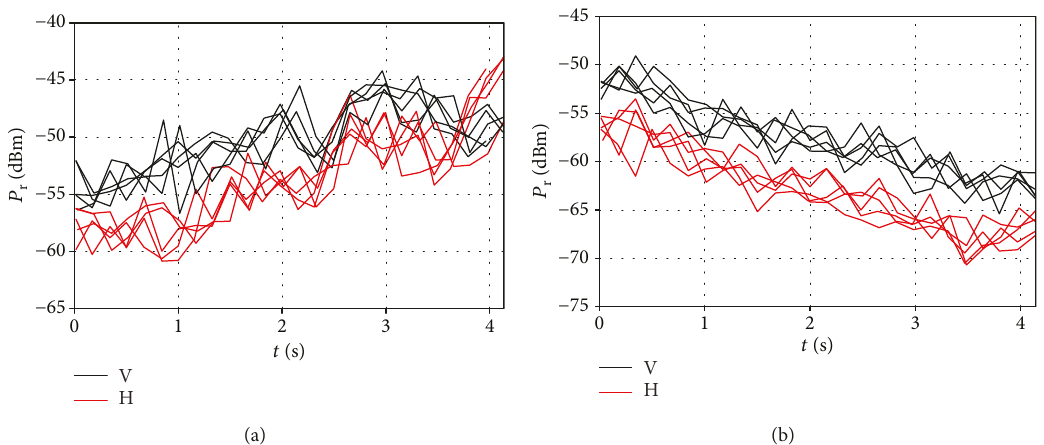
t ), for the V- and H-polarized on-body antenna placed on TO r ) vs. time (